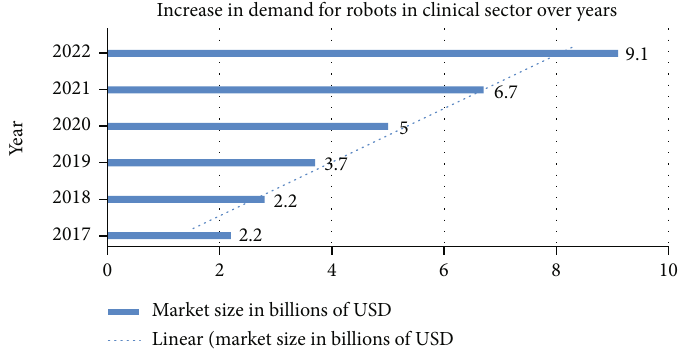
Figure 1: Market size of medical robots used worldwide